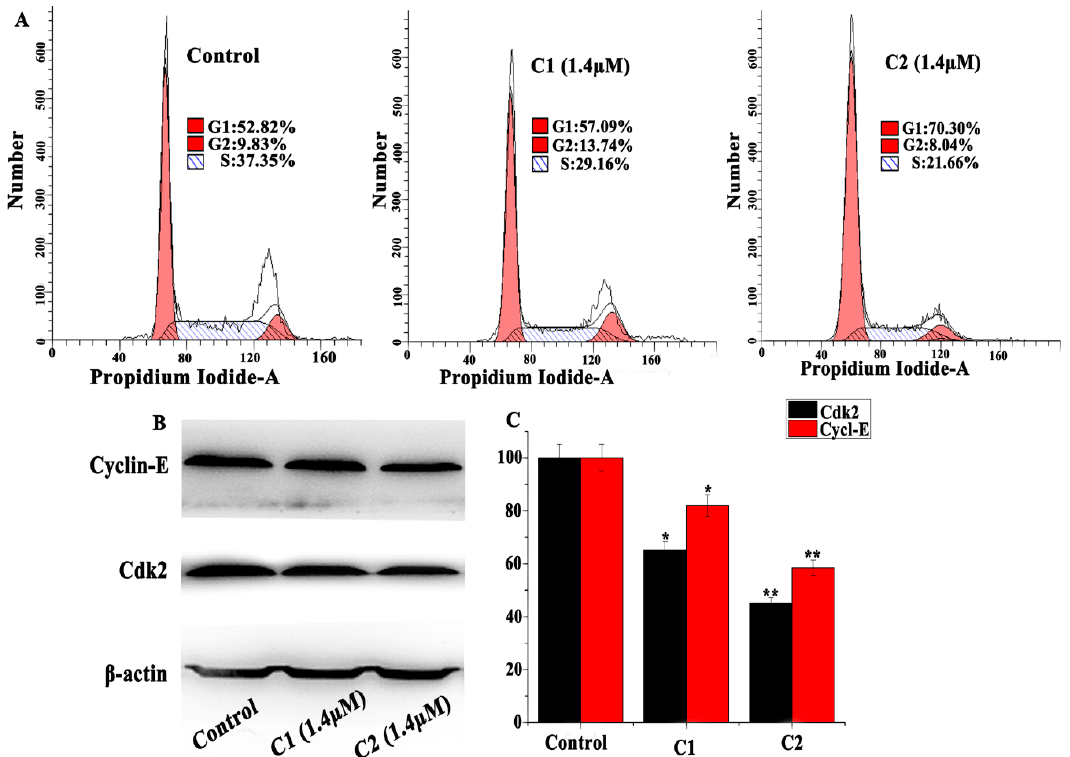
Figure 4. ( A ) Effect of the cell cycle of A-549 cells treated with C1 (1.4 μ M) and C2 (1.4 μ M) compared with untreated cells. ( B ) Western blot analysis of CDK2 and cyclin E in A-549 cells treated with C1 (1.4 μ M) and C2 (1.4 μ M). ( C ) Percentage expression levels of CDK2 and cyclin E. The percentage values are those relative to the control. Results are the mean ± SD, n = 3, * p < 0.05, ** p < 0.01.